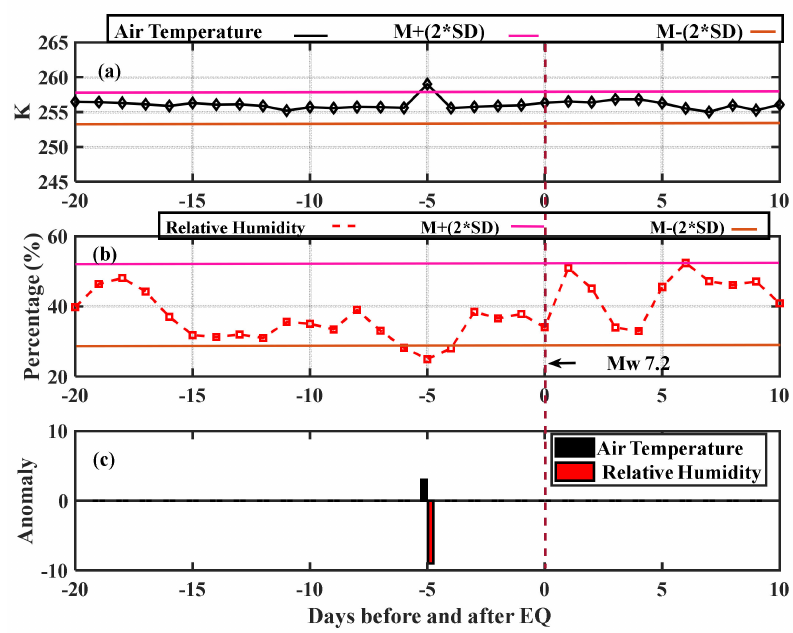
Figure 13. ( a ) AT time series, ( b ) RH time series over the epicentral zone with upper and lower bounds of mean and standard deviation, ( c ) deviation of AT time series values, and ST time series values from upper and lower bounds of mean and standard deviation. The red dashed line indicates the EQ